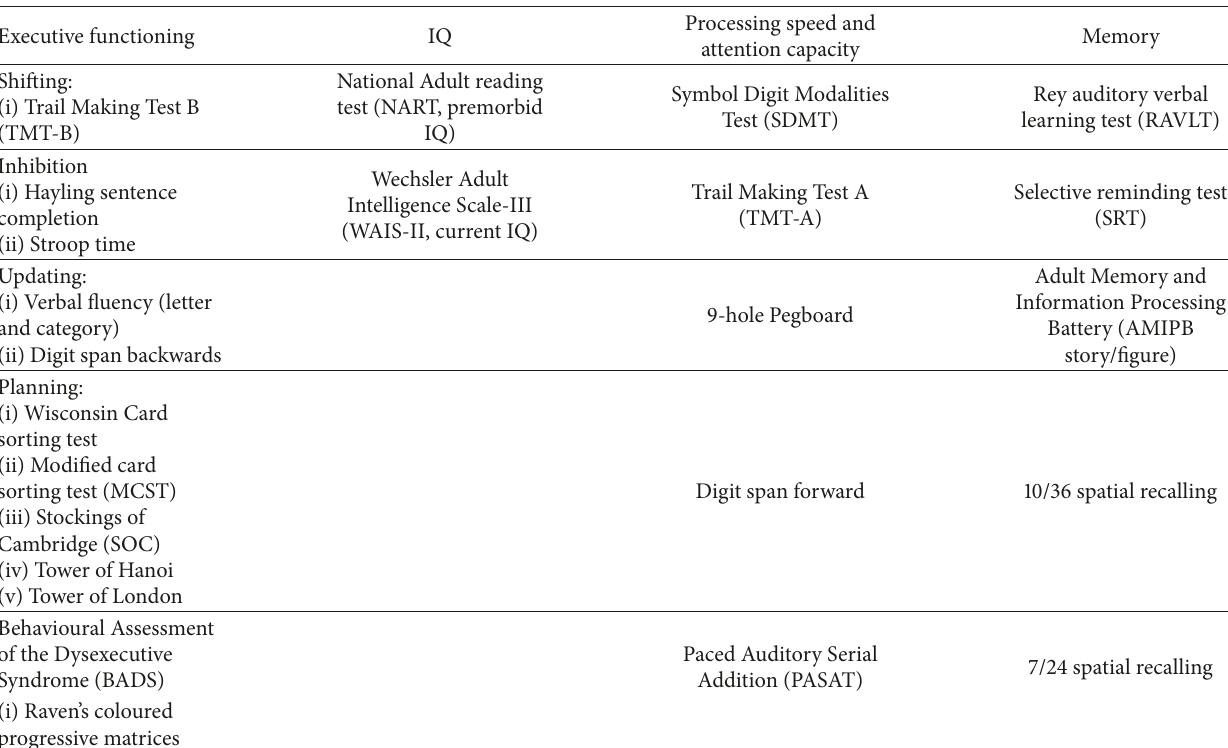
Table 1: Tests used to assess cognitive domains other than